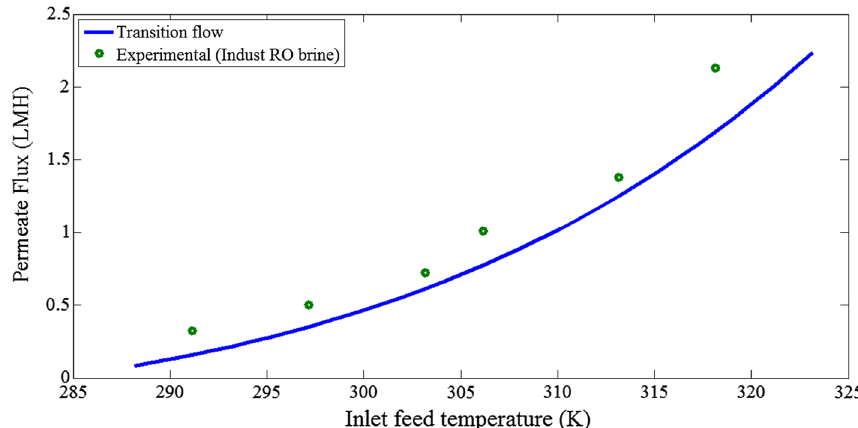
Fig. 12 A comparison between the transition flow model and experimental results for the industrial RO